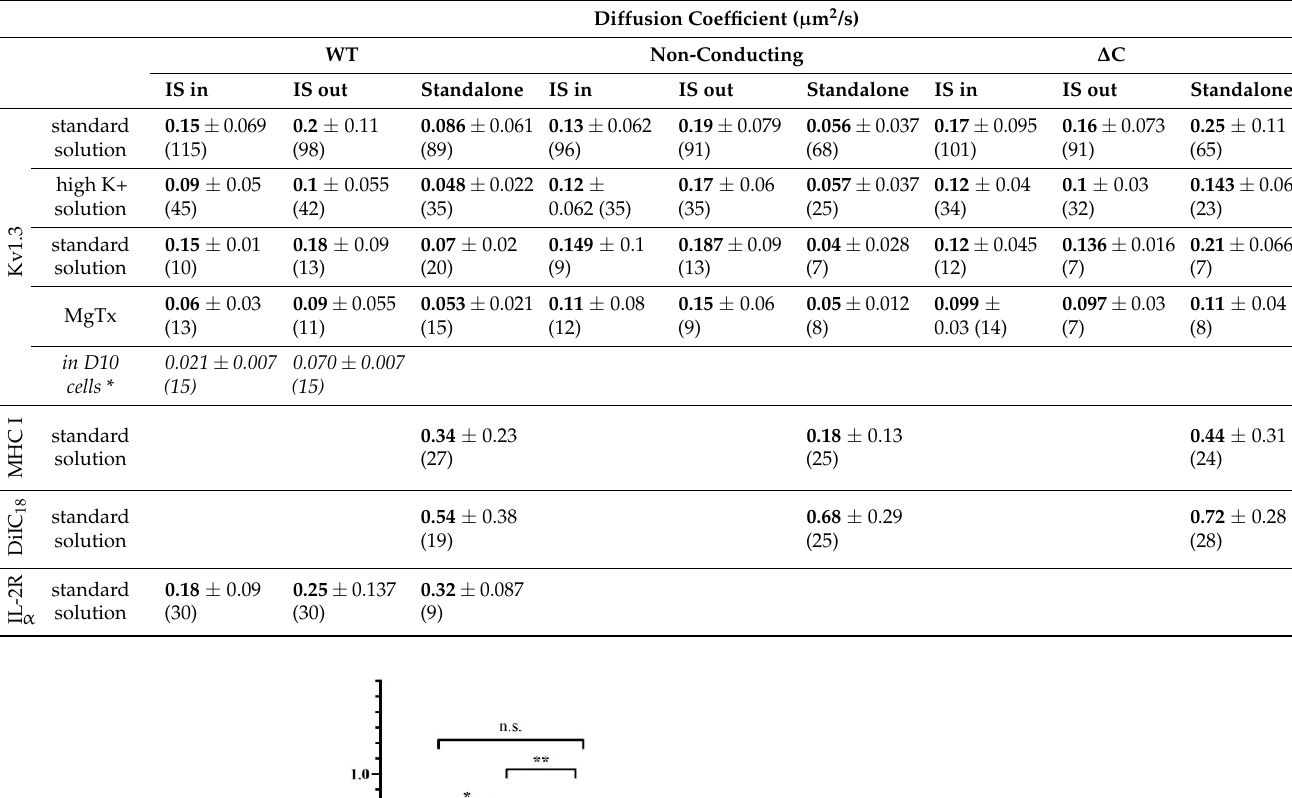
Table 1. Slow diffusion coefficient values of the examined molecules. Data are given in units of µ m 2 /s as mean ± standard deviation. Values in the brackets denote the number of measured points. We used Jurkat T cells (standalone or forming an IS with Raji B cells) unless mentioned otherwise. * Diffusion constant of mCherry-Kv1.3 was also determined in murine D10 cells forming an IS with CH12-LX B cells, using a model with a single diffusing component.